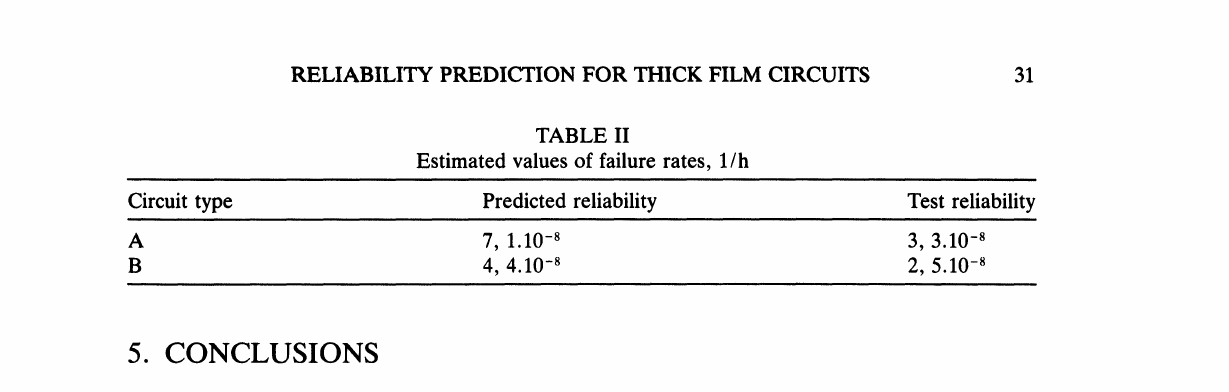
Estimated values of failure rates,